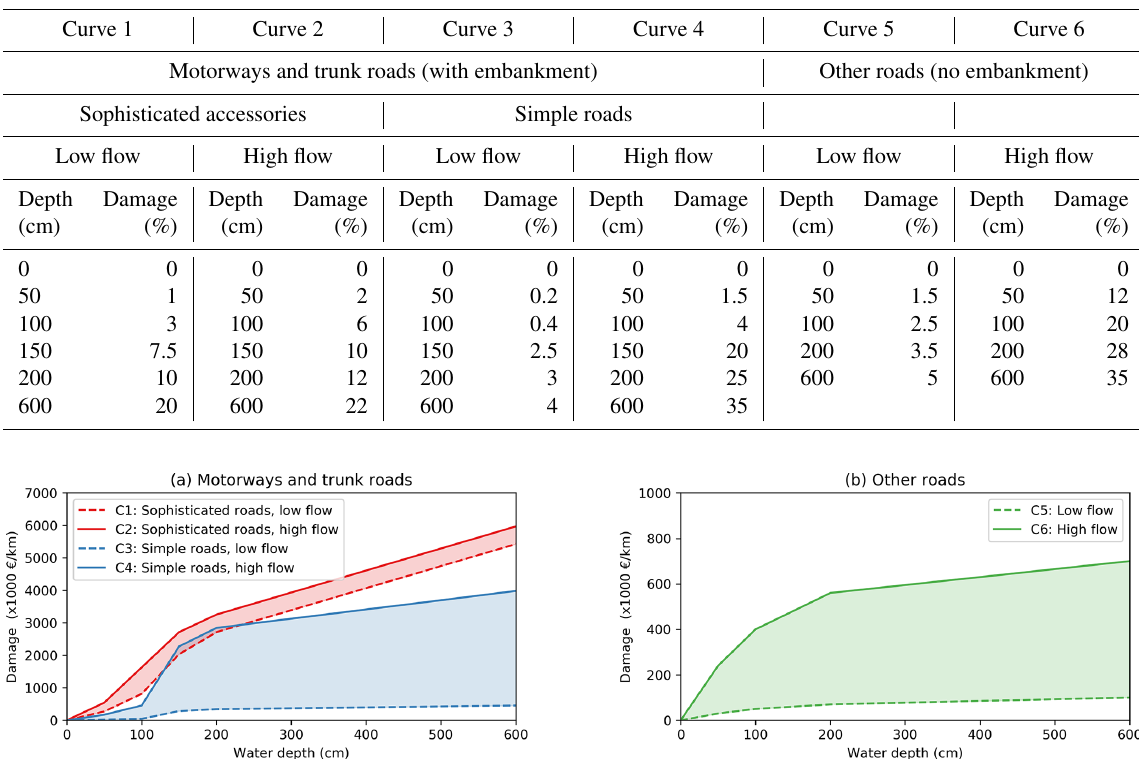
Figure 4. Damage curves for illustrative values of road construction costs, in euros per kilometre. (a) The curves for sophisticated roads (C1 and C2) are combined with the 75th percentile of the construction cost range for 2 × 2 lane motorways, and the curves for simple roads (C3 and C4) are combined with the 25th percentile. (b) These curves (C5 and C6) are combined with the 50th percentile of the construction costs of primary roads. The price level is the average of the former EU-28, in